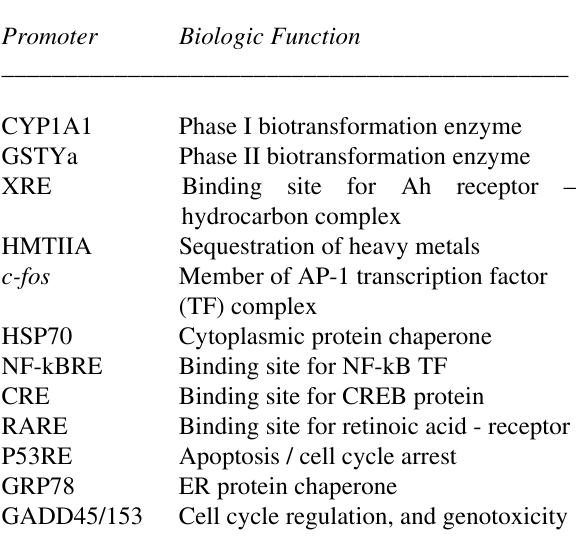
Table 1: Stress gene promoters/response elements-CAT- fusion constructs and their biologic